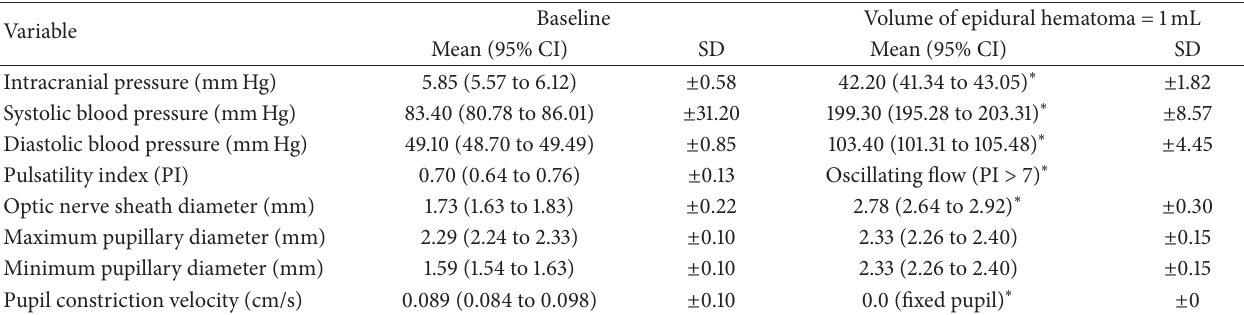
Table 1: Ultrasound and other parameters in the study group ( 𝑛 = 20 rabbits).